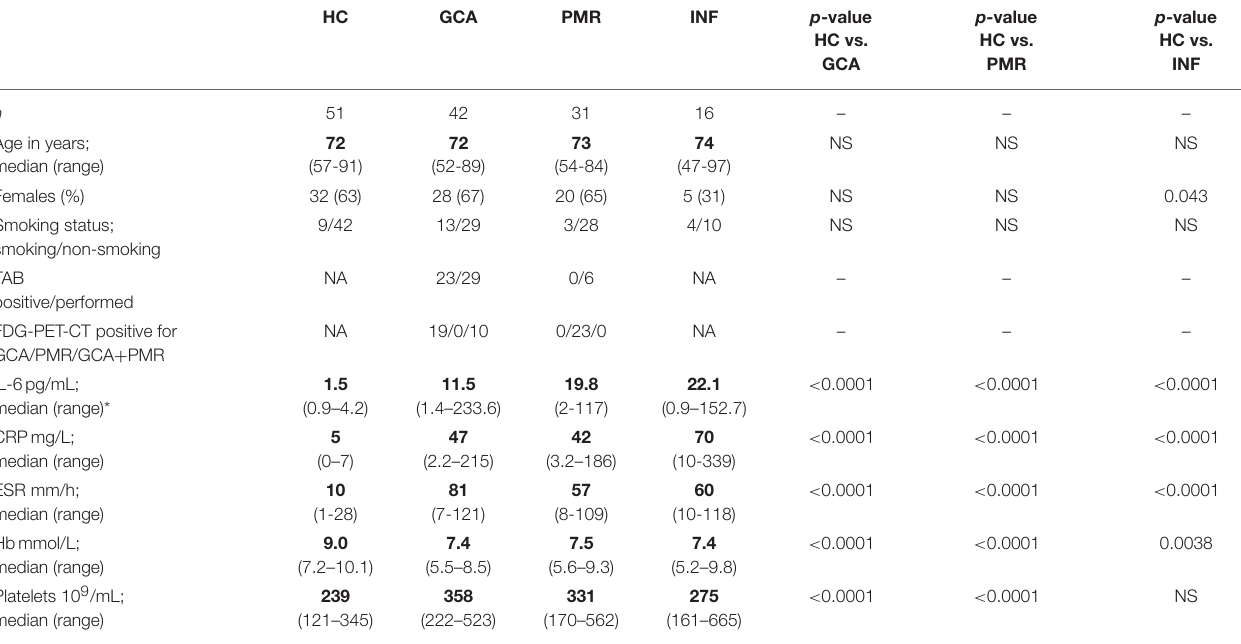
TABLE 1 | Pre-treatment characteristics of newly diagnosed, treatment-naive giant cell arteritis and polymyalgia rheumatica patients, aged healthy controls, and aged infection controls.